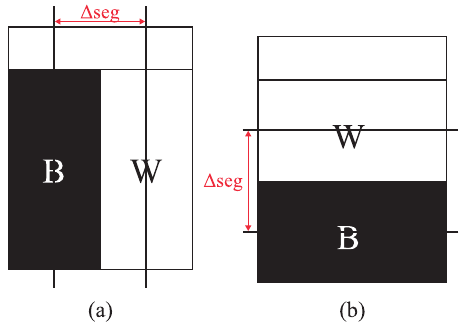
Fig. 1 Pre-organized particles with (a) black on the left and white on the right; (b) black on the bottom and white above in a